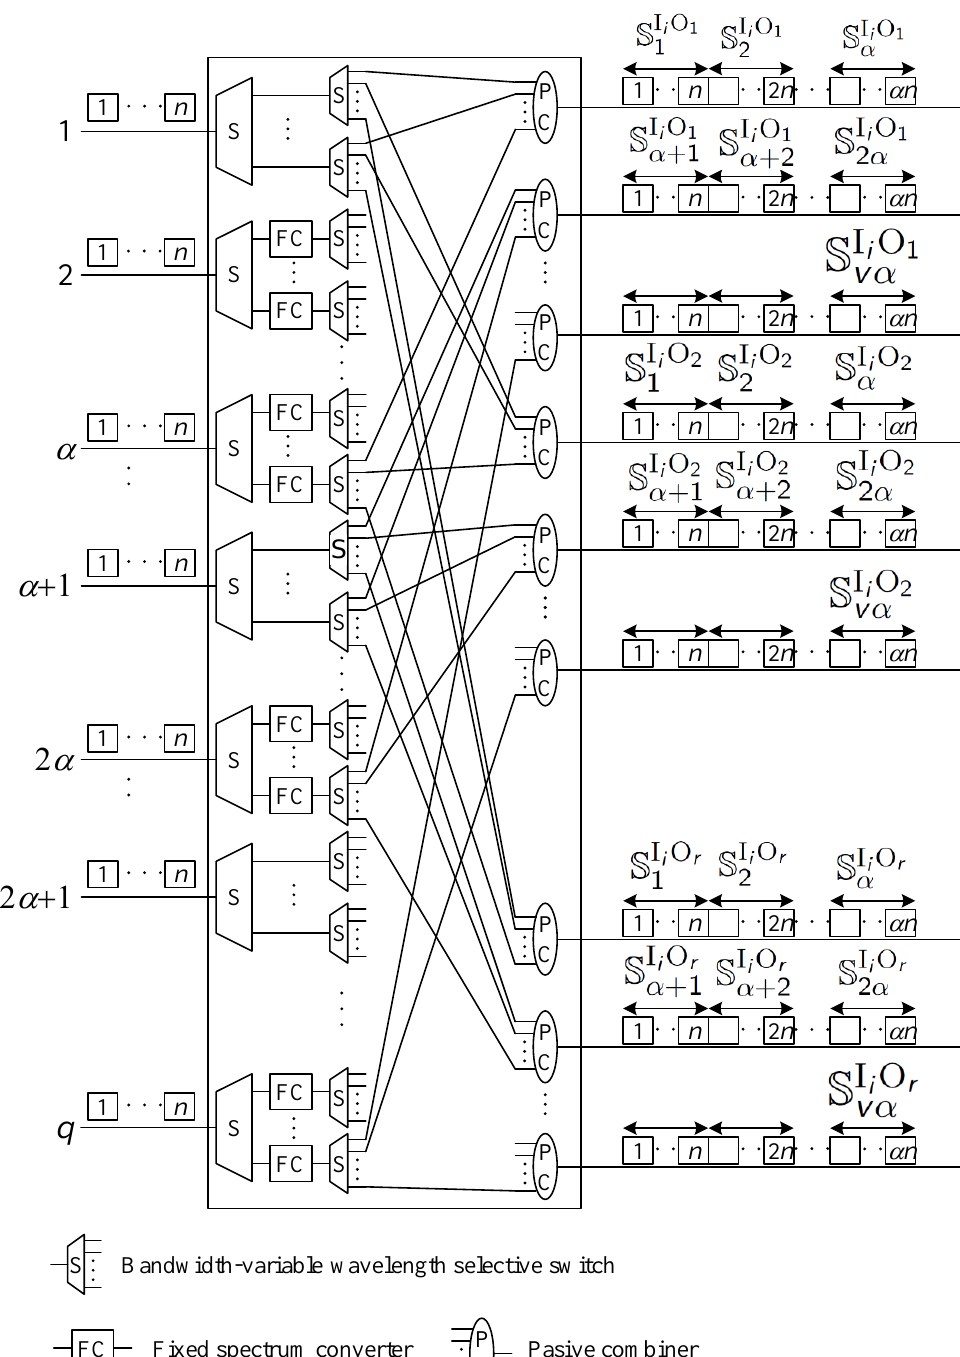
Figure 6. The I i switch with a reduced number of Fixed spectrum Converters